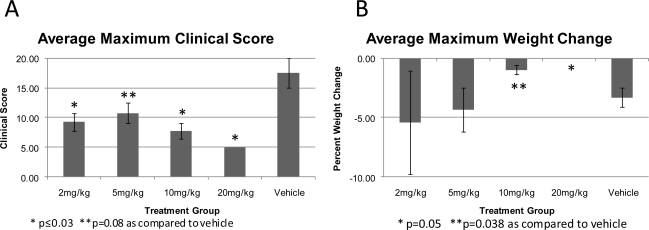
Disease severity measurements for evaluation of minimum dose of CMX001 required for protection from RPV when treatment is begun 1 day post infection. Animals were dosed at concentrations and schedules as outlined in Table 2. (A) Average maximum clinical scores for each animal per group over the course of the experiment. (B) Average maximum percent weight loss from weight at day 0 for each animal per group over the course of the experiment.